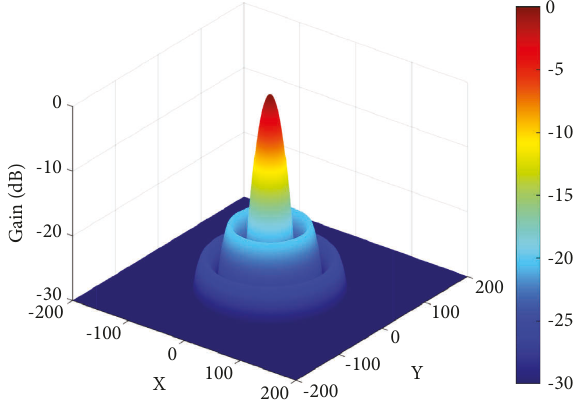
Figure 1: The schematic diagram of a Gaussian antenna